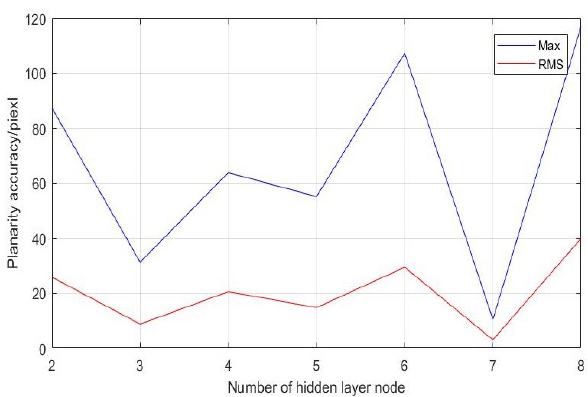
Figure 4. The terrain-depedent BP neural network imagery geometrical model accuracy of dataset 1 with different hidden layer node The node number of hidden layer in BP neural network imagery geometrical model training does not effect the RMS